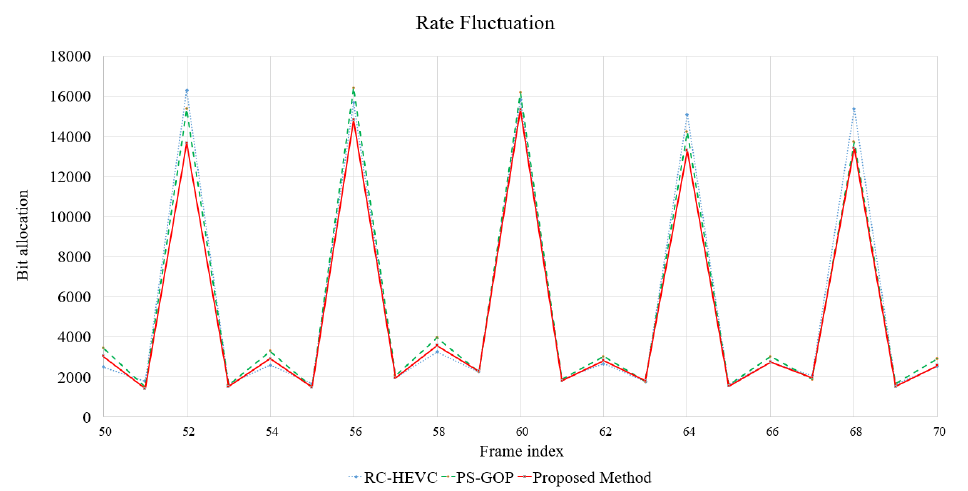
Figure 6. Rate fluctuation performance